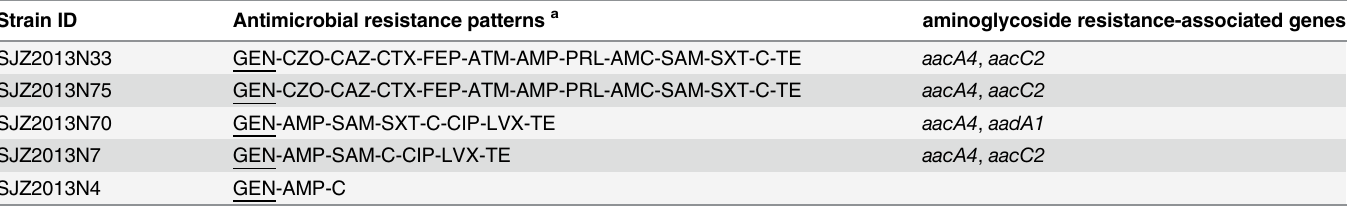
Table 5. Characteristics of the Aminoglycoside Resistance-Associated Genes in 5 Gentamicin-Resistant or Intermediately Gentamicin-Resistant K . pneumoniae Isolates Detected in this Study. Strain ID Antimicrobial resistance patterns